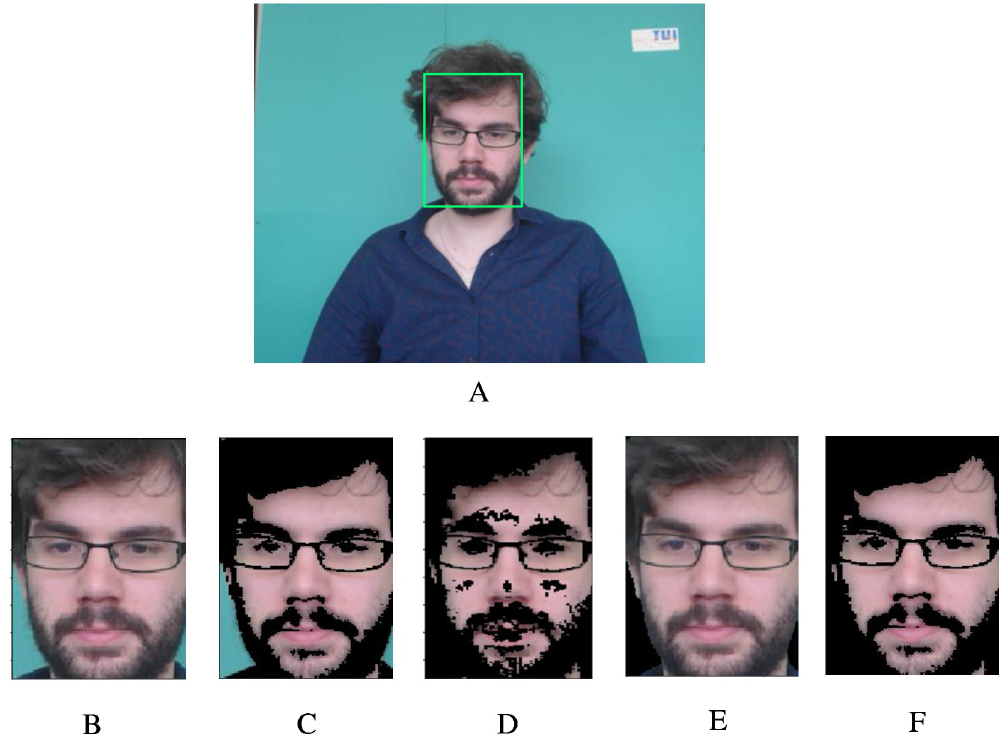
Fig 2. Face and skin detection results. A:The result of face detection. B:The cropped face. C * F: The skin detection results of RGB, YCrCb, YCrCb+OTSU, RGB-H.